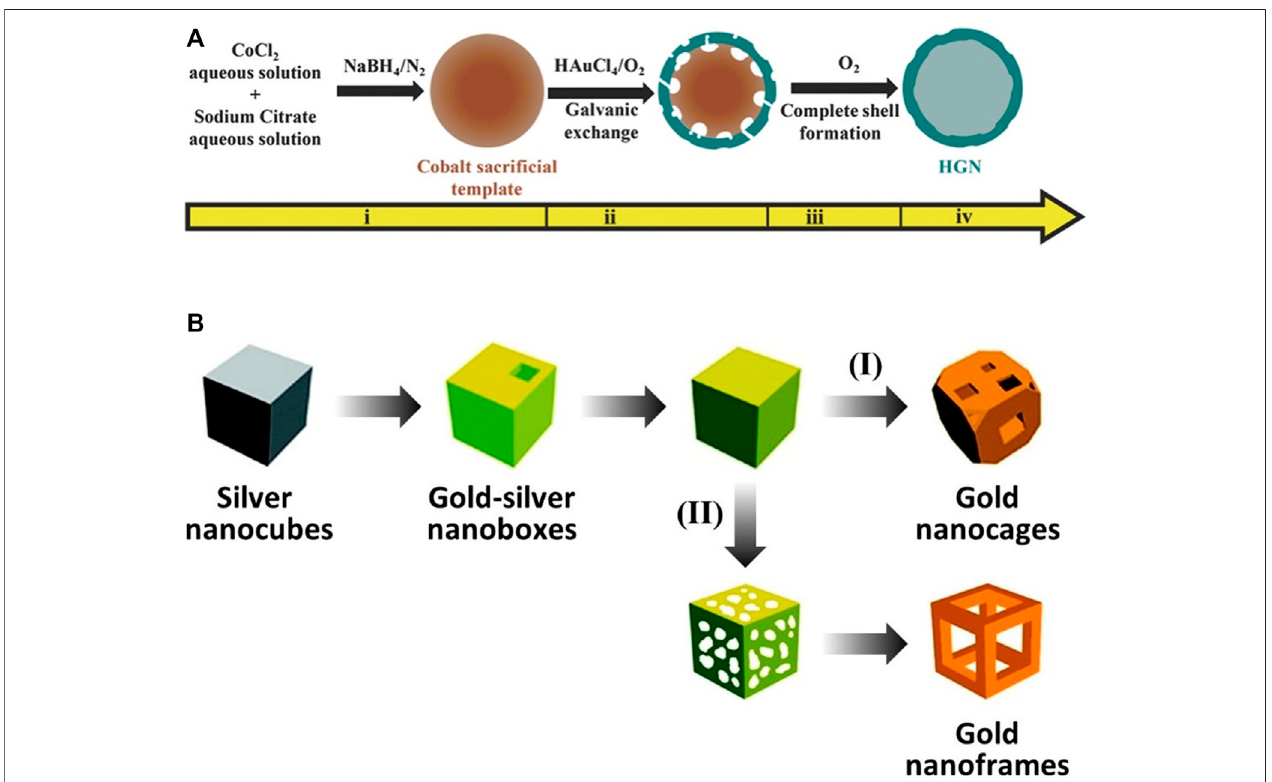
FIGURE 4 | Schematic illustration of the synthesis of hollow gold nanostructures based on the galvanic replacement method. (A) Hollow gold nanospheres using cobalt nanospheres as sacri fi cial templates. (B) Gold nanocages/frames using silver nanocubes as sacri fi cial templates. (A) Reprinted with permission from Pu et al. (2017). Copyright 2016, WILEY-VCH Verlag GmbH and Co. KGaA, Weinheim. (B) Reprinted with permission from Skrabalak et al. (2008). Copyright 2008, American Chemical Society.